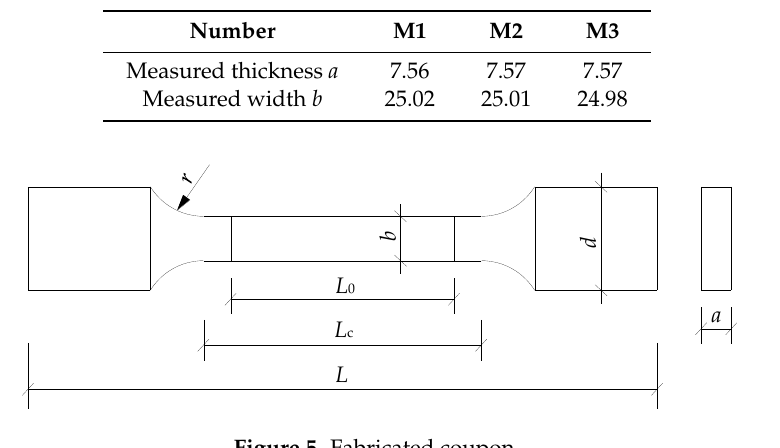
Table 4. Measured sizes of LYP steel coupons (unit: mm).